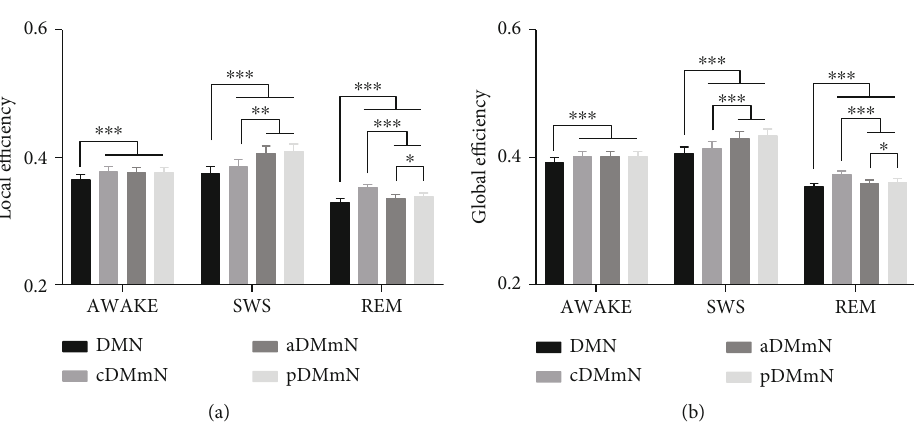
Figure 6: The local and global e ffi ciency of the three CAMP networks and the DMN in each state of consciousness. (a) Comparisons of local e ffi ciency. (b) Comparisons of global e ffi ciency. ∗ indicates a signi fi cant di ff erence with p < 0 : 05 . ∗∗ indicates a very signi fi cant di ff erence with p < 0 : 01 . ∗∗∗ indicates the most signi fi cant di ff erence with p < 0 : 001